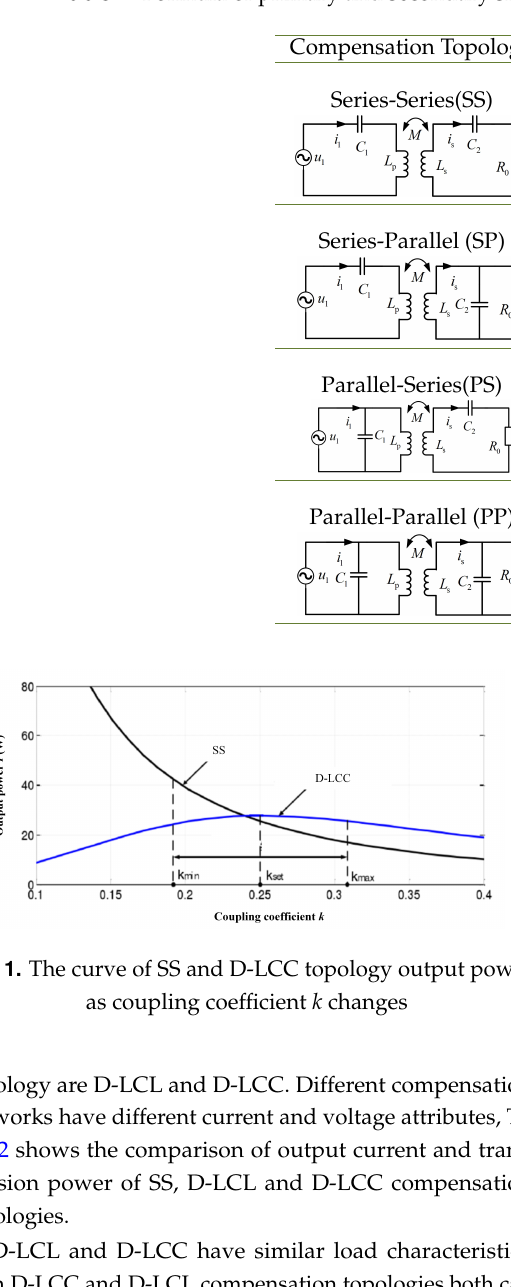
Table 1. Formula of primary and secondary side compensation capacitance of basic resonant topology